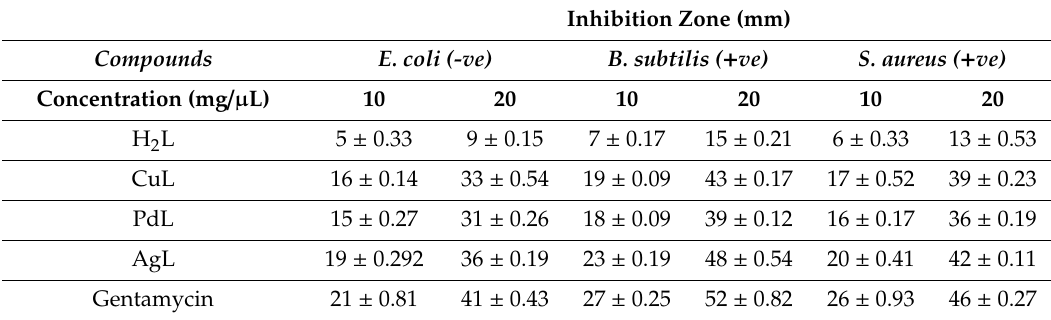
Table 5. Antibacterial bioassay results of the prepared compounds against studied strains of bacteria compared to gentamycin.